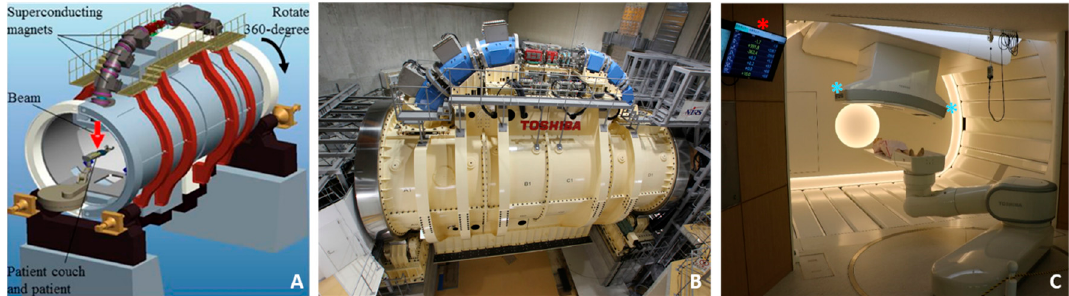
Figure 4. ( A ) Schematic diagram of the actual gantry seen in ( B ). Superconducting magnets, beam